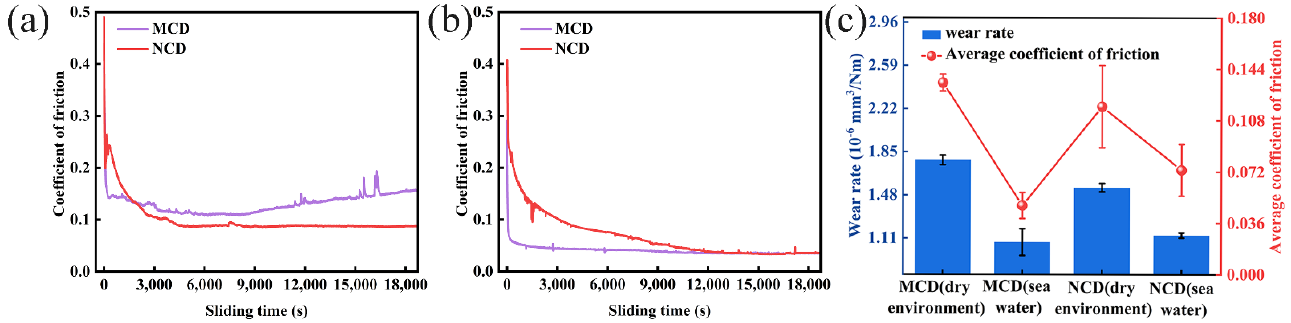
Figure 4. ( a ) Friction coefficient of diamond coatings in the dry environment; ( b ) Friction coefficient of diamond coatings in the seawater environment; ( c ) Average wear rate and average friction coefficient of diamond coatings.